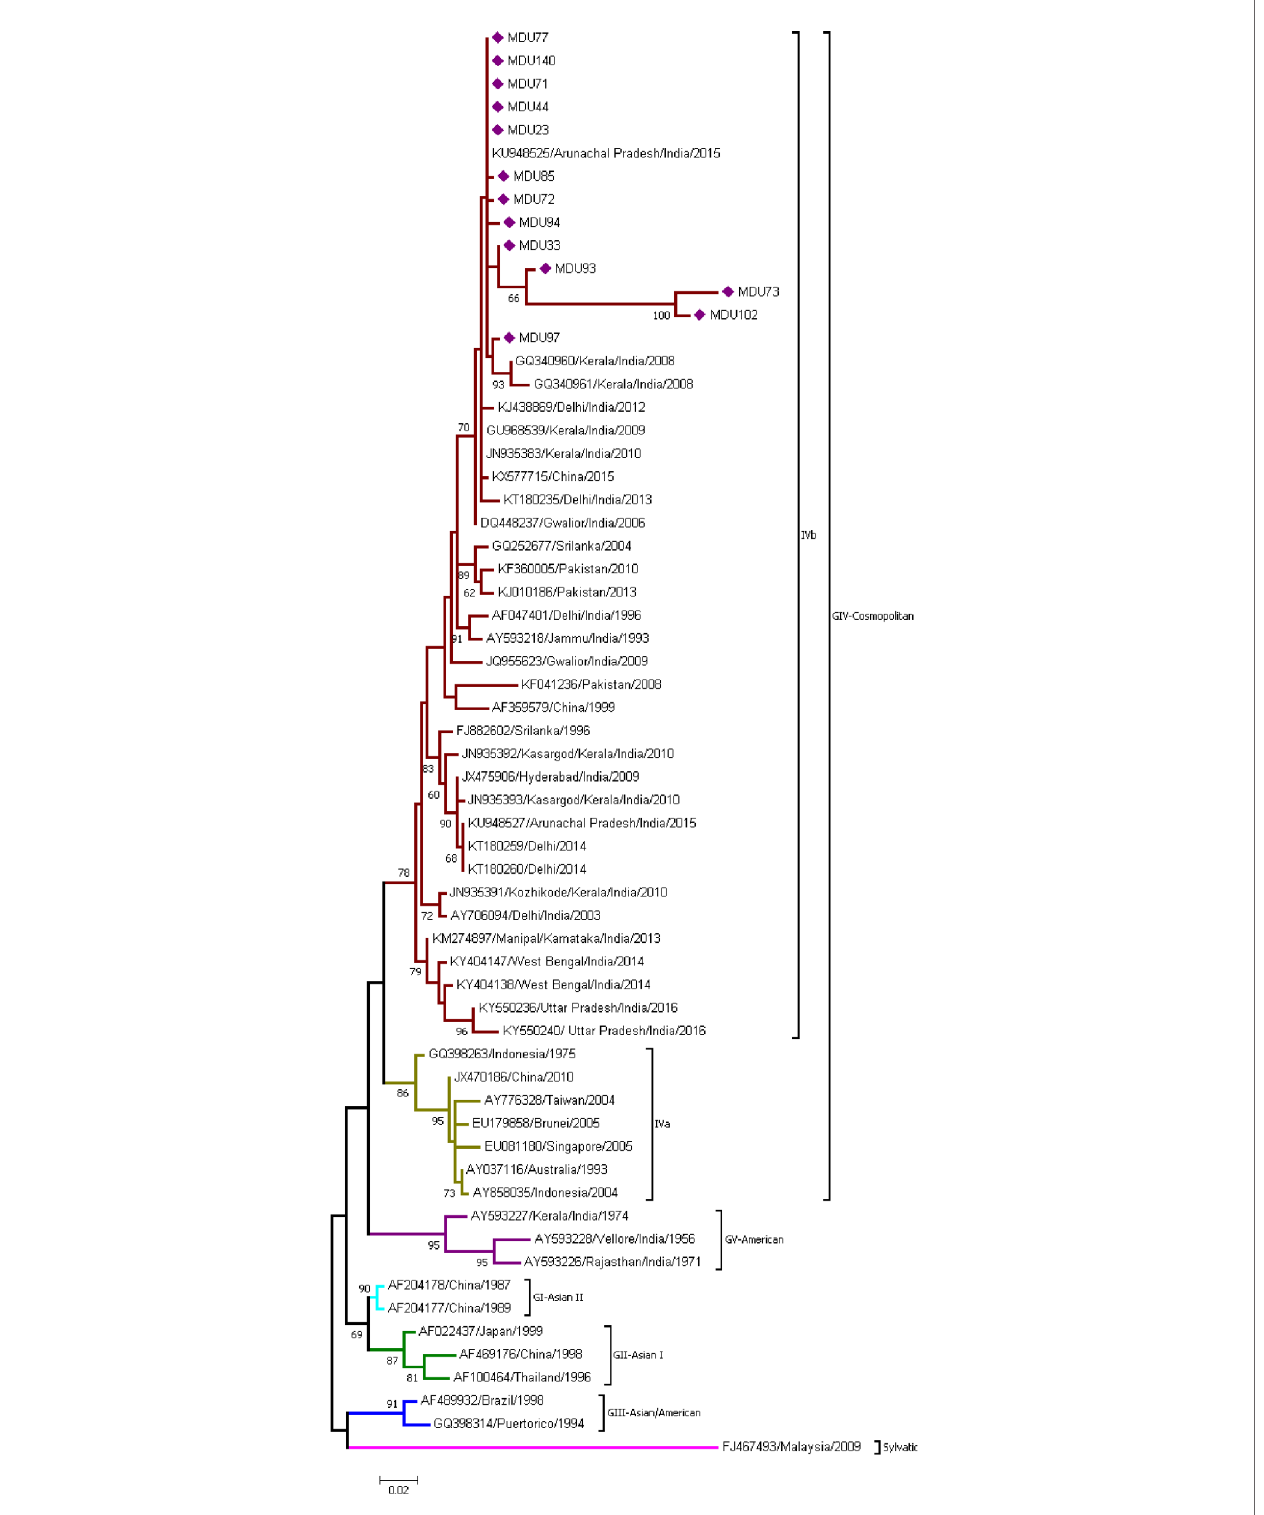
FIGURE 2 | Phylogeny of DENV-2. The phylogeny of DENV-2 was inferred by using the ML method. The tree with the highest log likelihood (-2,176.94) is shown. The analysis involved 61 nucleotide sequences. There was a total of 324 positions in the fi nal dataset. All the 13 sequences from this study were under GIV- cosmopolitan group and merged with clade B (IVb). Nucleic acid substitution per position was calculated as